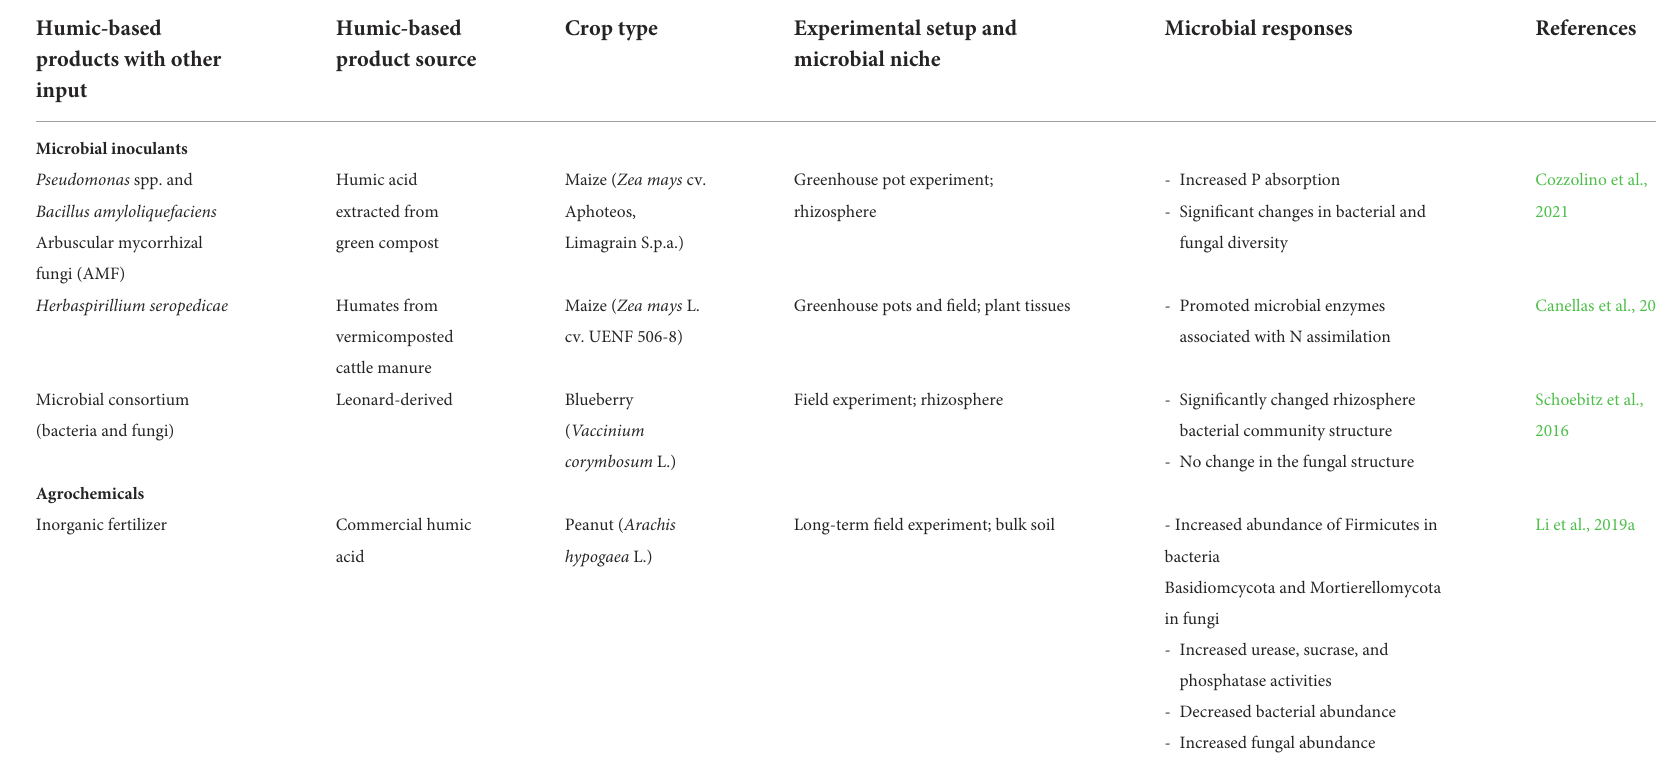
TABLE 2 The effect of humic-based products with other inputs on microbial community and